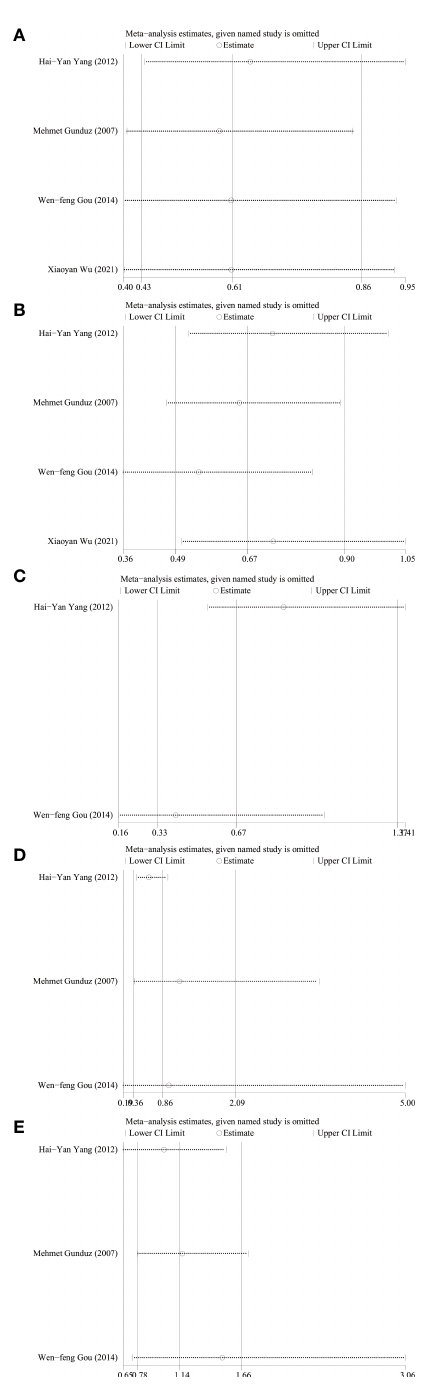
FIGURE 6 Sensitivity analysis for relationship between ING3 expression and TNM stage (A) , lymph node metastasis (B) , tumor size (C) , tumor differentiation (D) and gender (E)